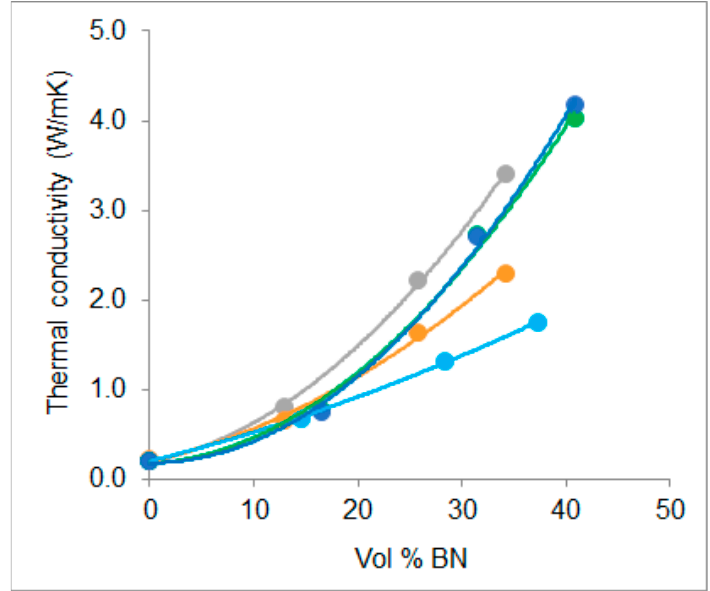
Figure 10. Plot of thermal conductivity of epoxy-BN systems as a function of vol % BN: epoxy-diamine, light blue; ETLBN6, orange; ETLBN80, grey; ETLBN80/2, green; ETLBN80/6, dark blue.